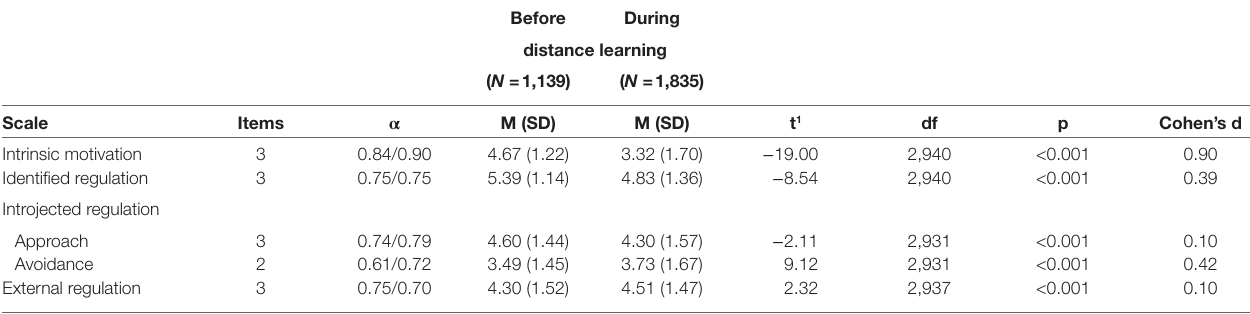
TABLE 1 | Motivational regulations before and during the forced distance learning period.